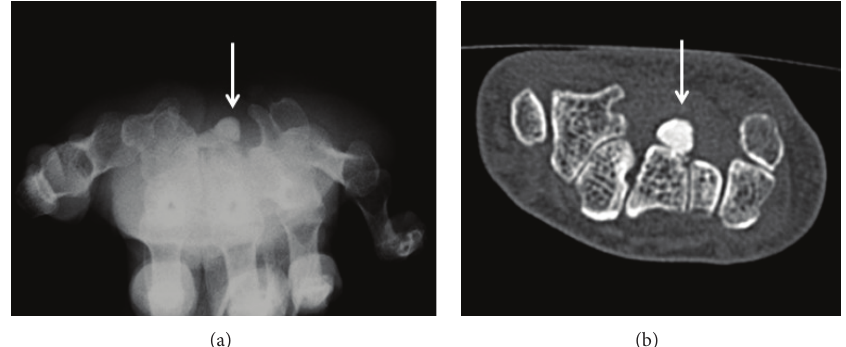
Figure 1: A plain radiograph showing a calcified mass on the volar surface of the wrist joint (a). A computed tomogram showing a lesion that has a high-density mass (b).